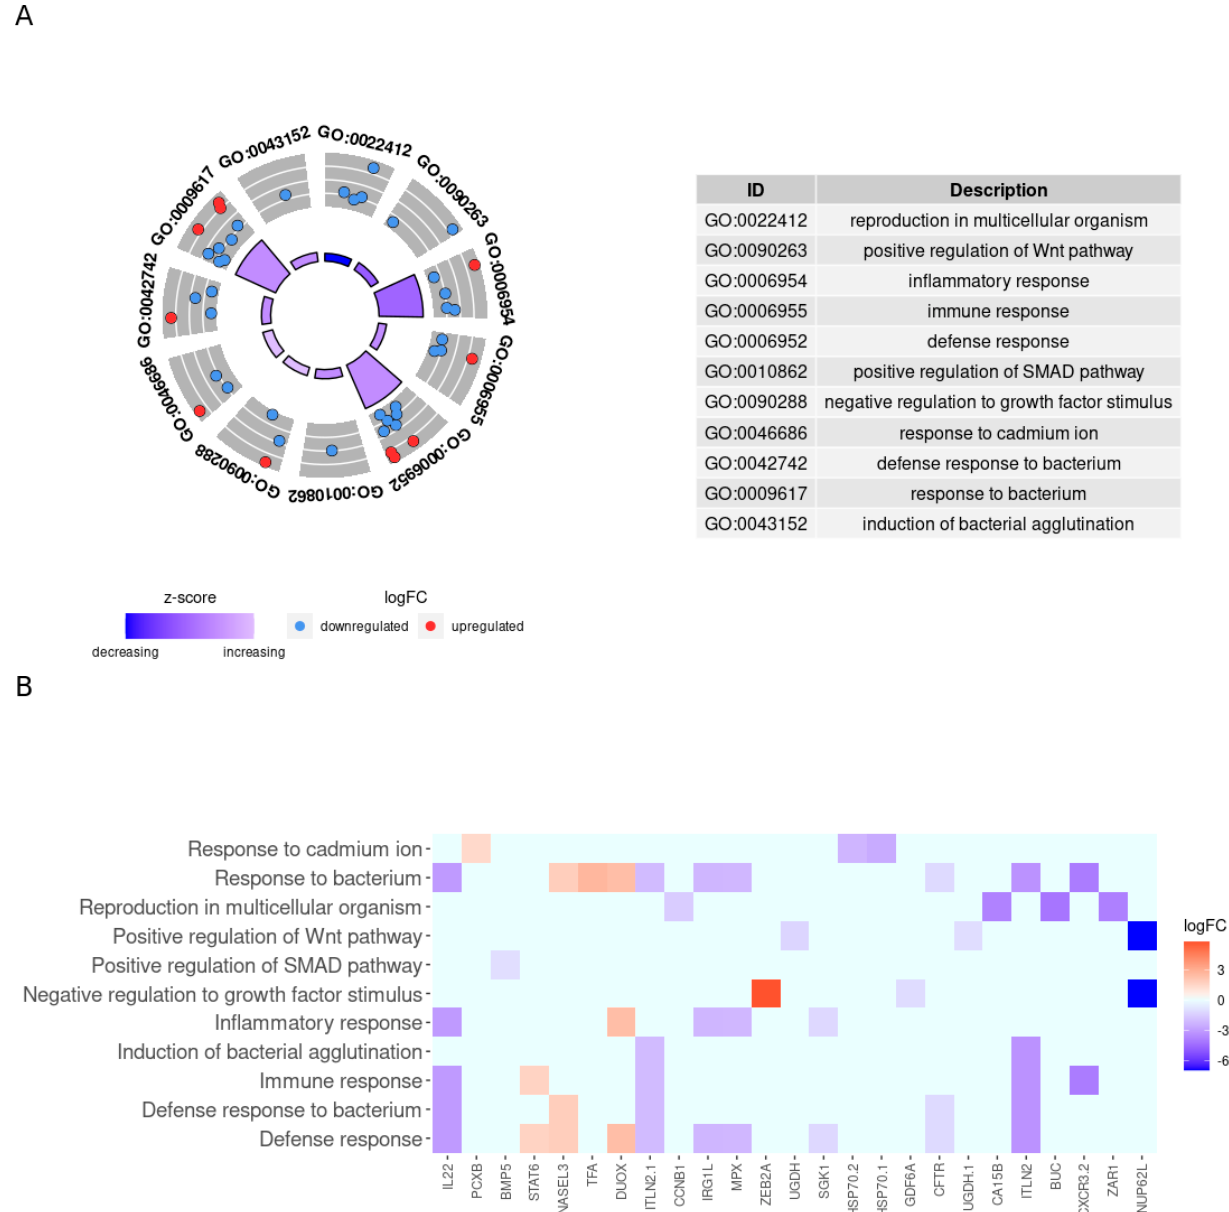
Figure 2. Enriched biological processes decreased in HG-50SBM + 2SPN fish and associated genes. ( A ) Circle plot of decreased biological processes in HG-50SBM + 2SPN fish. The red and blue dots on the gray ring represent the up- or downregulated genes, respectively, that participate in each process. The GO IDs of the biological processes are noted on the outer ring. The inner ring represents the z-score, and the color intensity indicates the degree to which the enriched biological process is decreased. The table on the right shows the name of each biological process by GO ID. ( B ) Heatmap of the 25 genes participating in biological processes decreased in HG-50SBM + 2SPN fish. Genes are presented as squares. Red indicates an upregulated gene, while blue indicates a downregulated gene.